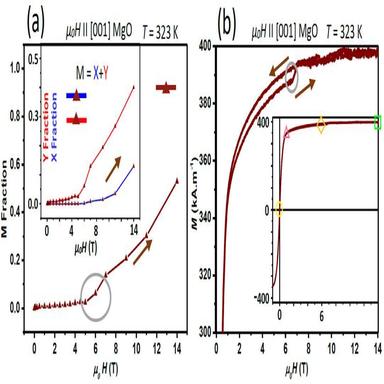
a) Martensitic transition curves constructed from the isothermal MFM images at 323 K 4, Fig. S6), showing the martensitic fraction of the scanned area upon applying external magnetic field up to 14 T normal to the film plane. The inset in (a) shows the evolution of the X-type fraction (blue) and Y-type fraction (red) of the martensitic phase vs. external field (M = X + Y). b) Magnetization curves of the same sample vs. external magnetic field (μ0H = −1.0 to 14.0 T) along MgO at 323 K. The curve